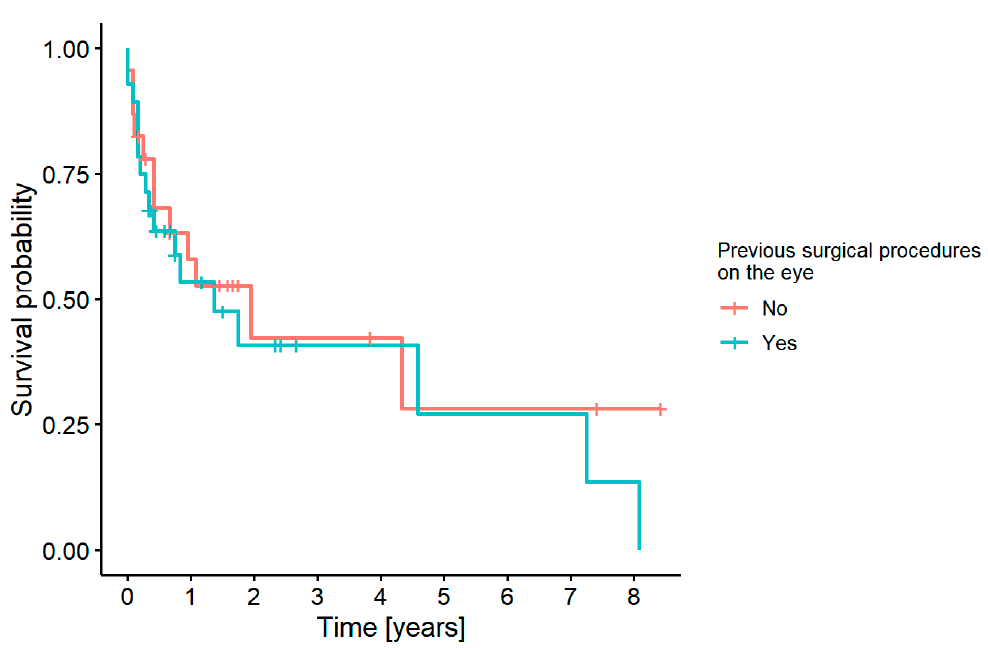
Figure 8. Survival probability for females and males.